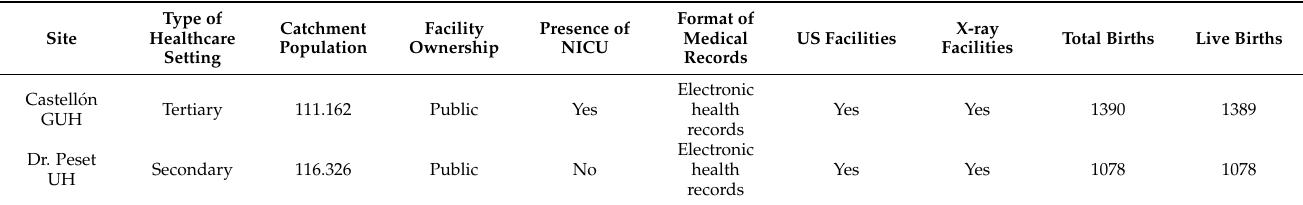
Table 1. Characteristics of participant hospitals and number of total births and live births during the study period. US: Ultrasound.